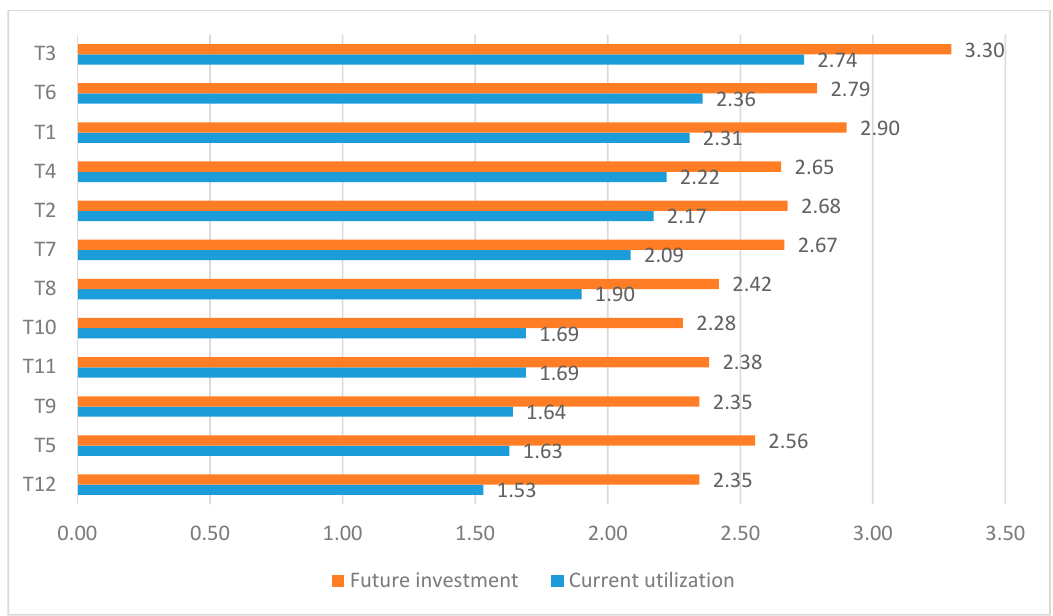
Figure 3. Average scores of current utilization level and future investment level.